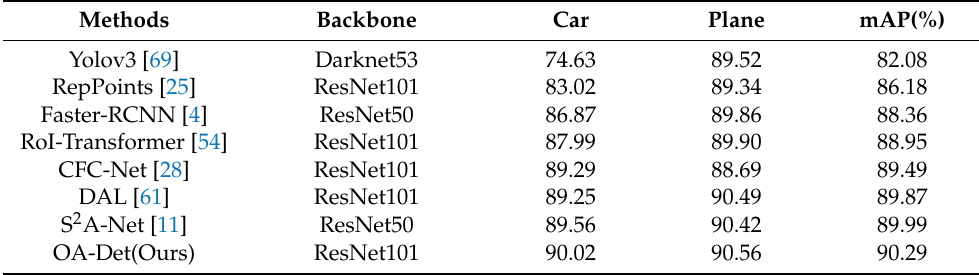
Table 9. Comparisons with high-quality detection performance on UCAS-AOD